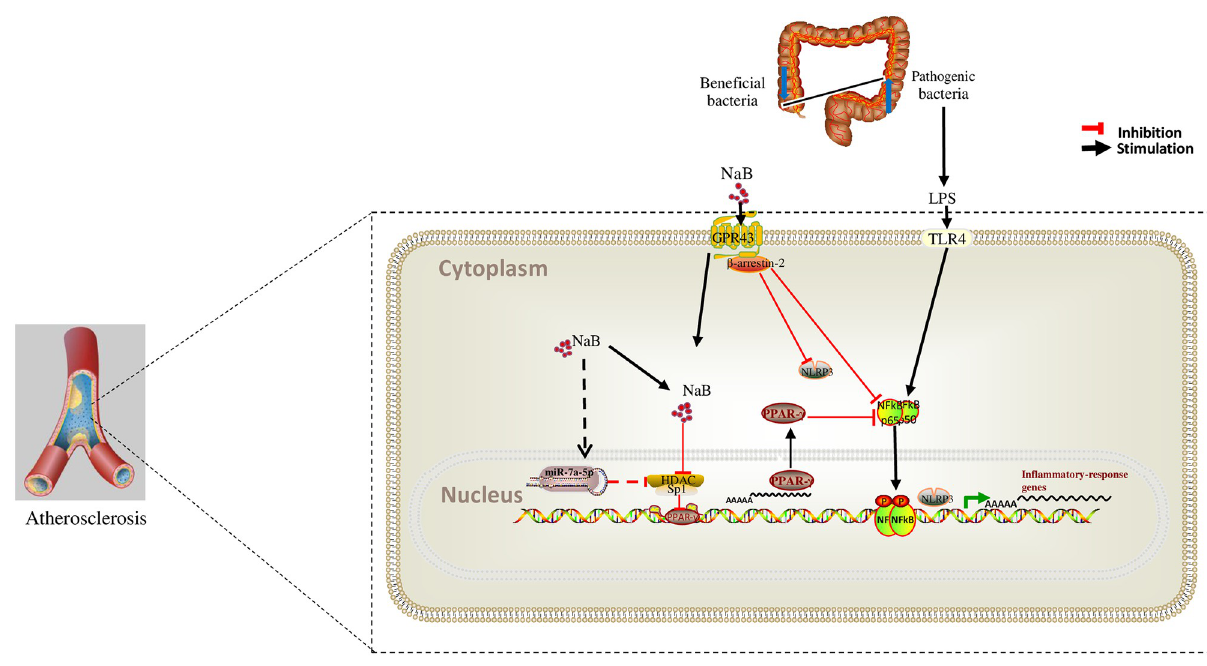
Fig 9. Schematic diagram of anti-inflammation effect of NaB in